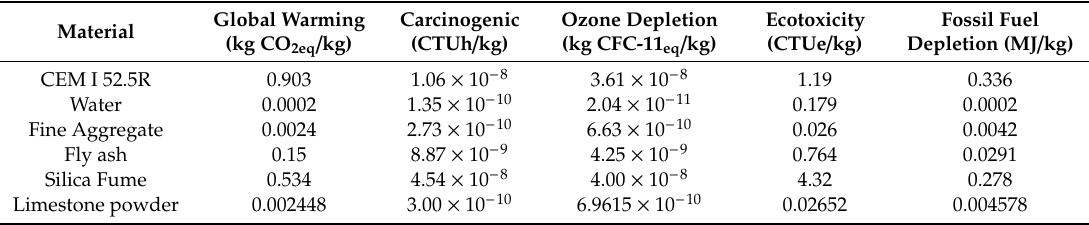
Table 8. Unit environmental impact for used